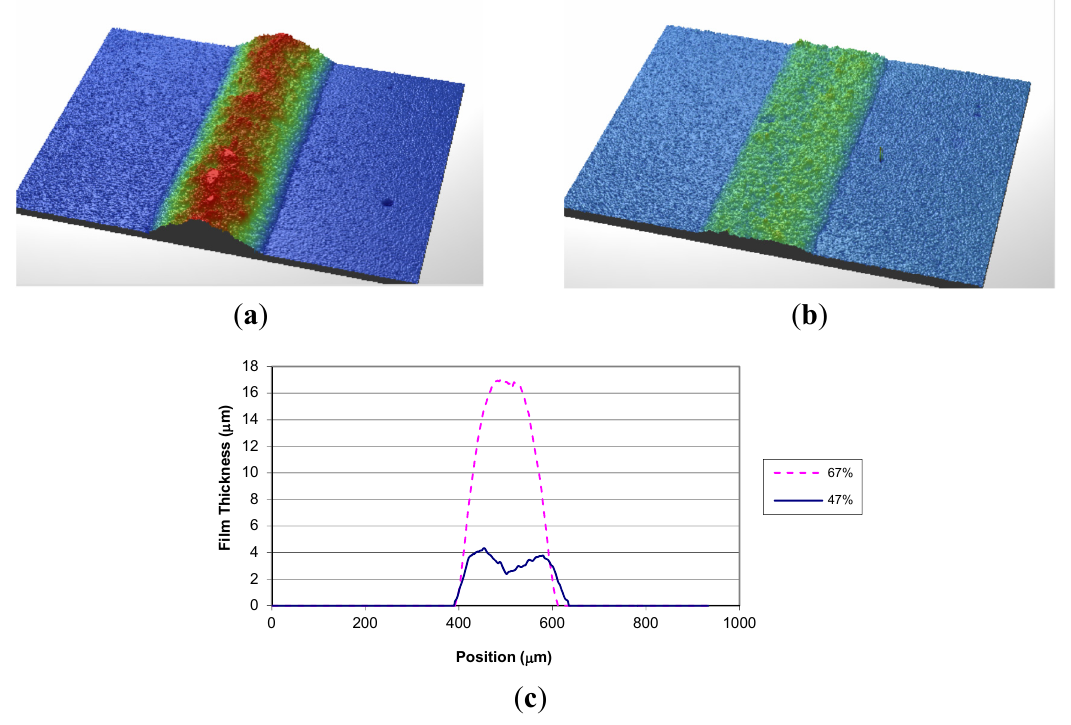
Figure 8 . A comparison of the cross section of the printed lines through the polyester 195 threads/cm screen. ( a ) 3D view of 67% material; ( b ) 3D view of 47%; and ( c ) Mean cross section through